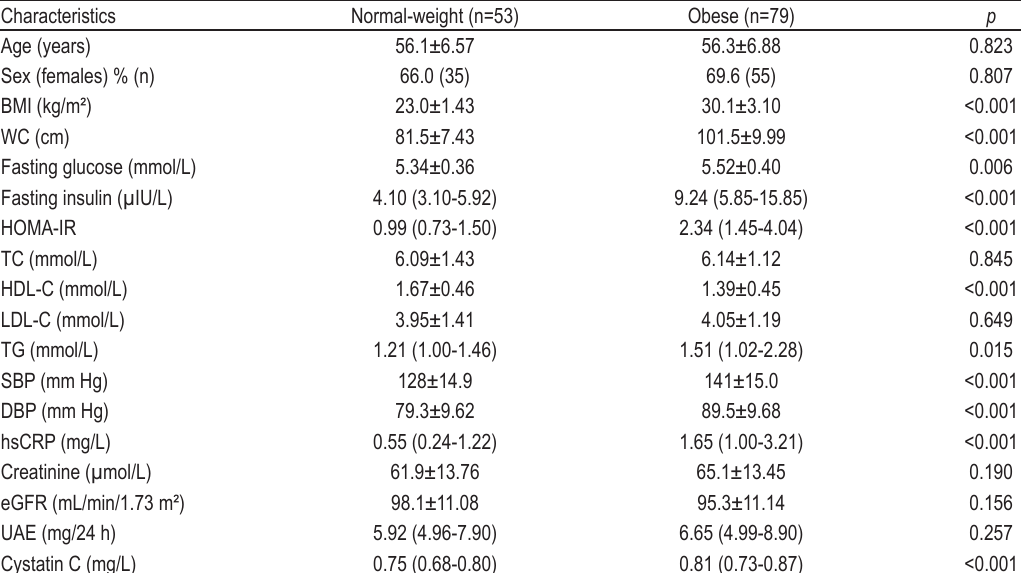
TABLE 1. General characteristics of studied participants